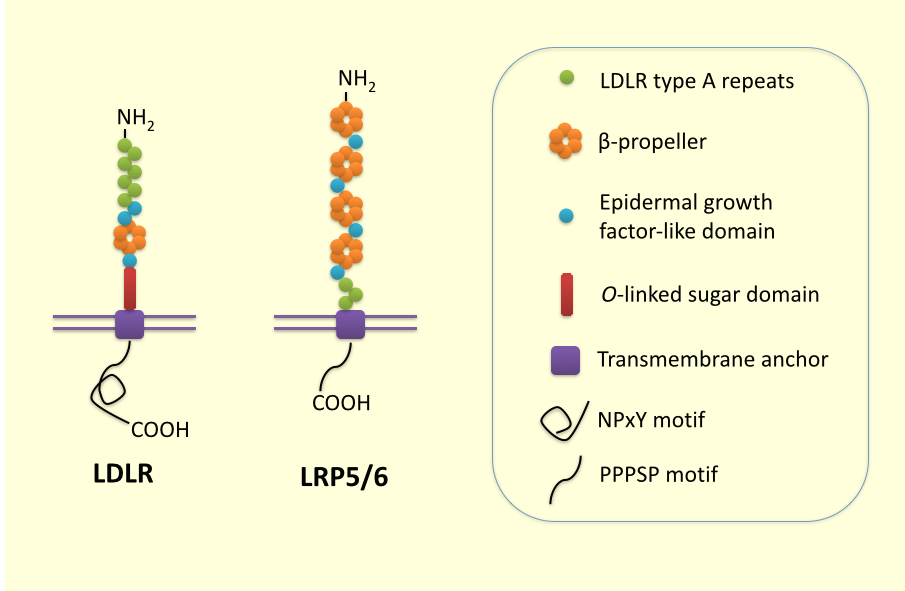
Figure 1. Structure of low-density lipoprotein receptor (LDLR) and low-density lipoprotein receptor-related protein 6 (LRP6). LDLR is the patriarch of the LDLR family members, which include LRP6. LDLR and LRP6, and share structurally common motifs: LDLR type A repeats (responsible for binding of ligands), an epidermal growth factor (EGF)-like domain